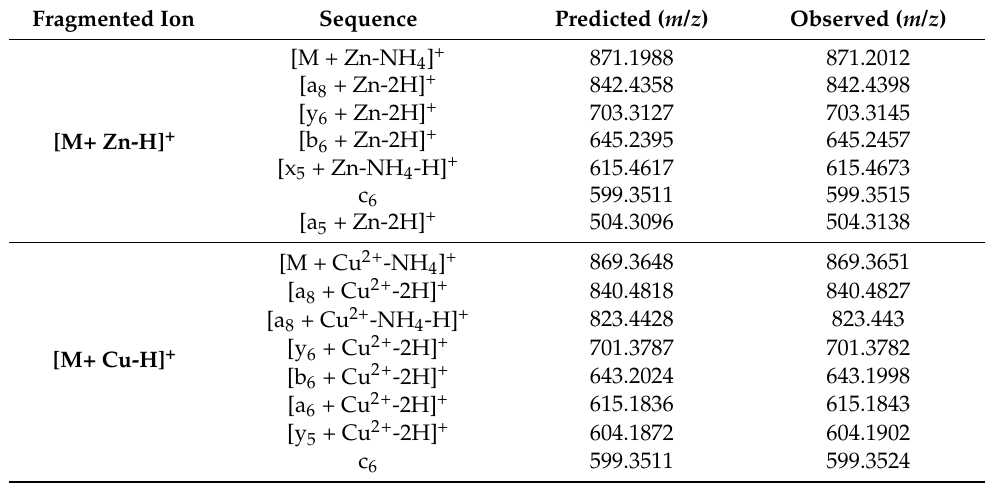
Figure 7. Tandem mass spectrometry (MS/MS) spectrum of the singly charged ( A ) [M + Zn-H] + ion at m / z 887.4 and ( B ) [M + Cu-H] + ion at m / z 886.4, showing the x, y, z and a, b fragments of the peptide sequence. Table 1. Collision-induced dissociation of [M + Zn-H] + and [M + Cu-H] + ions. Fragmented Ion